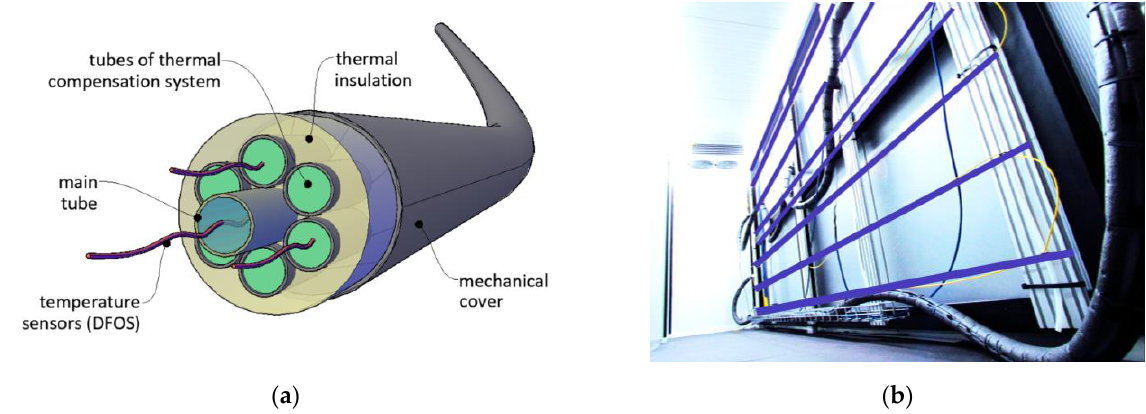
Figure 12. ( a ) Distributed optical fibers installed within the sensor body for dynamic measurements; ( b ) view of the framework inside the cold chamber equipped with distributed fiber optic sensors for static temperature measurements.